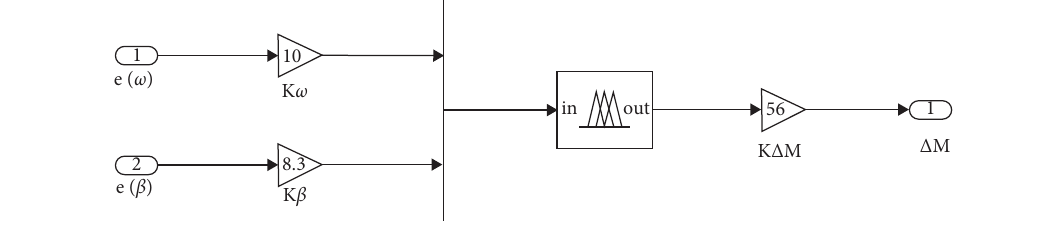
Figure 2: Diagram of the fuzzy controller. Table 2: ESP fuzzy logical rules.